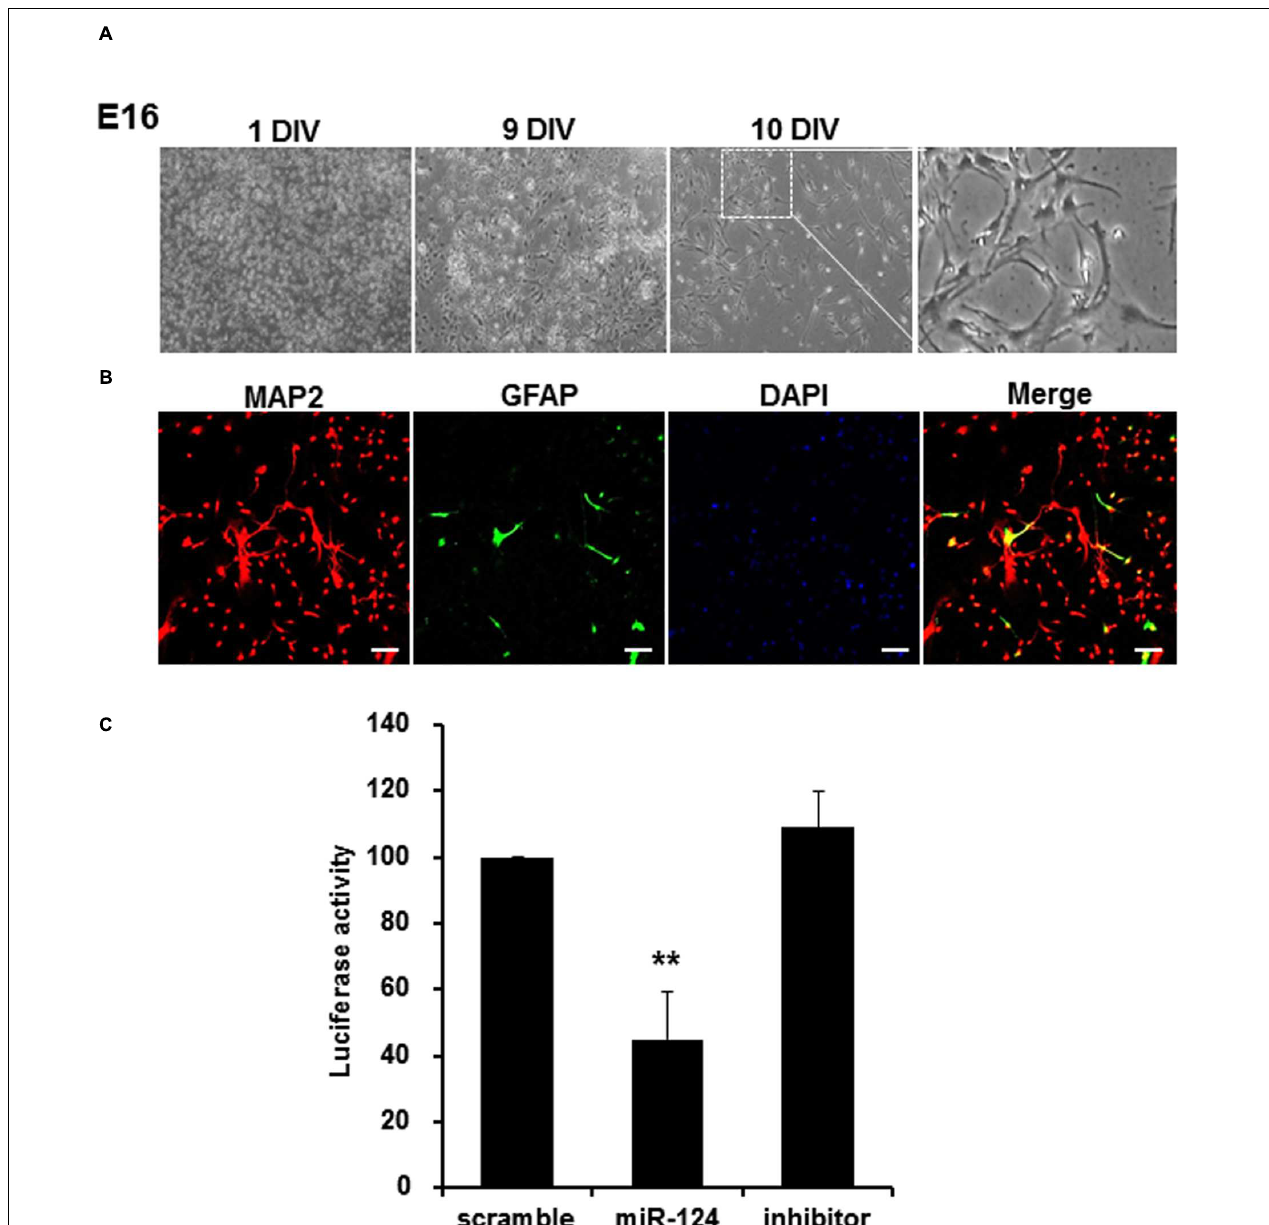
FIGURE 5 | MiR-124 reduces luciferase activity in the cortical neurons extracted and cultured from transgenic mouse. (A) Cortical neurons from E16 of transgenic mouse were cultured for 10 days in vitro (DIV). Images were displayed with phase-contrast microscope using 4 × or 100 × magnification (inset). The scale bars represent 200 µ m (low-scaled panel) and 50 µ m (magnified panel). (B) Immunocytochemistry with anti-MAP2 (microtubule-associated protein-2, red, and labeling neurons) and anti-GFAP (Glial fibrillary acid protein, green, and labeling astrocytes) antibodies counterstained with DAPI were shown with confocal microscope using a 100 × magnification. The scale bars represent 100 µ m. 95% were MAP2 positive and the other 5% were GFAP positive. (C) Primary cultured cortical neurons which were transfected with scramble, miR-124, or miR-124 inhibitor at DIV 10, showed reduction of luciferase activity only with miR-124. The results were normalized as percent ratios to the scramble treatment. Data were represented by means ± SD ( n = 6, ∗∗ p < 0.01).